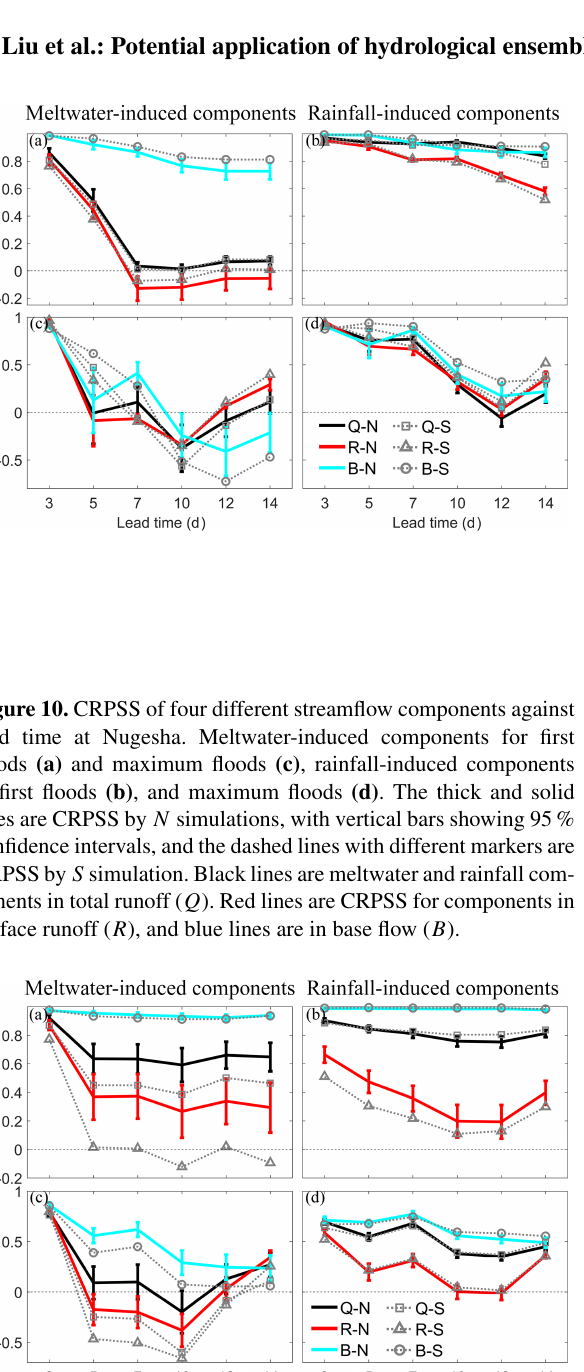
Figure 11. CRPSS of four different streamflow components against lead time at Yangcun. Meltwater-induced components for first floods (a) and maximum floods (c) and rainfall-induced compo- nents in first floods (b) and maximum floods (d) . The thick and solid lines are CRPSS by N simulations, with vertical bars showing 95% confidence interval, and the dashed lines with different markers are CRPSS by S simulation. Black lines are snowmelt and rainfall com- ponents in total runoff ( Q ). Red lines are CRPSS for components in surface runoff ( R ), and blue lines are in base flow ( B ).